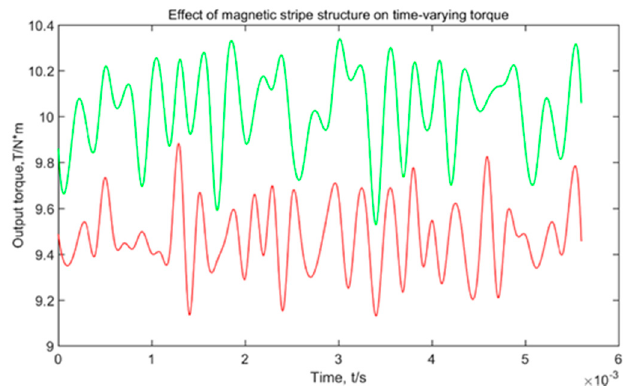
Figure 3. Effect of the magnetic stripe structure on the time-varying torque. Figure 3. E ff ect of the magnetic stripe structure on the time-varying torque.